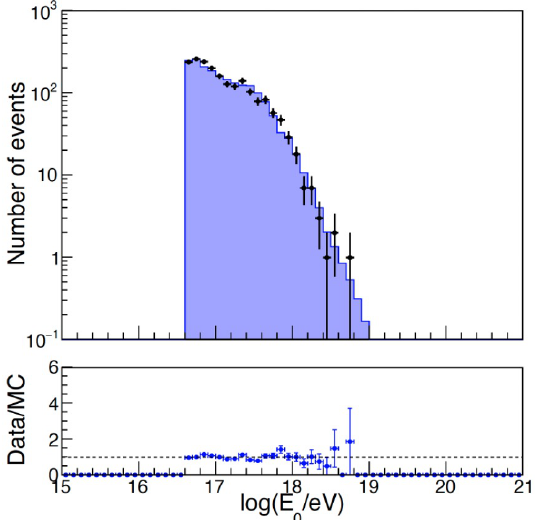
Figure 6. Energy distribution. The data are shown by marker points and the MC prediction are shown by histogram. The MC predictions are normalized with the number of events in the data.